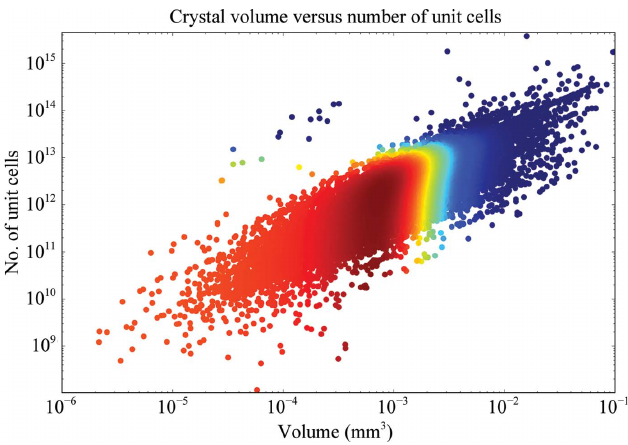
Figure 5 Number of unit cells plotted against crystal volume. There is a large spread across three orders of magnitude in the number of unit cells in the highest count bins. The smallest number of unit cells in a crystal that yielded a data set was 2.3 (cid:5) 10 8 . Data points are coloured by KDE. N = 15